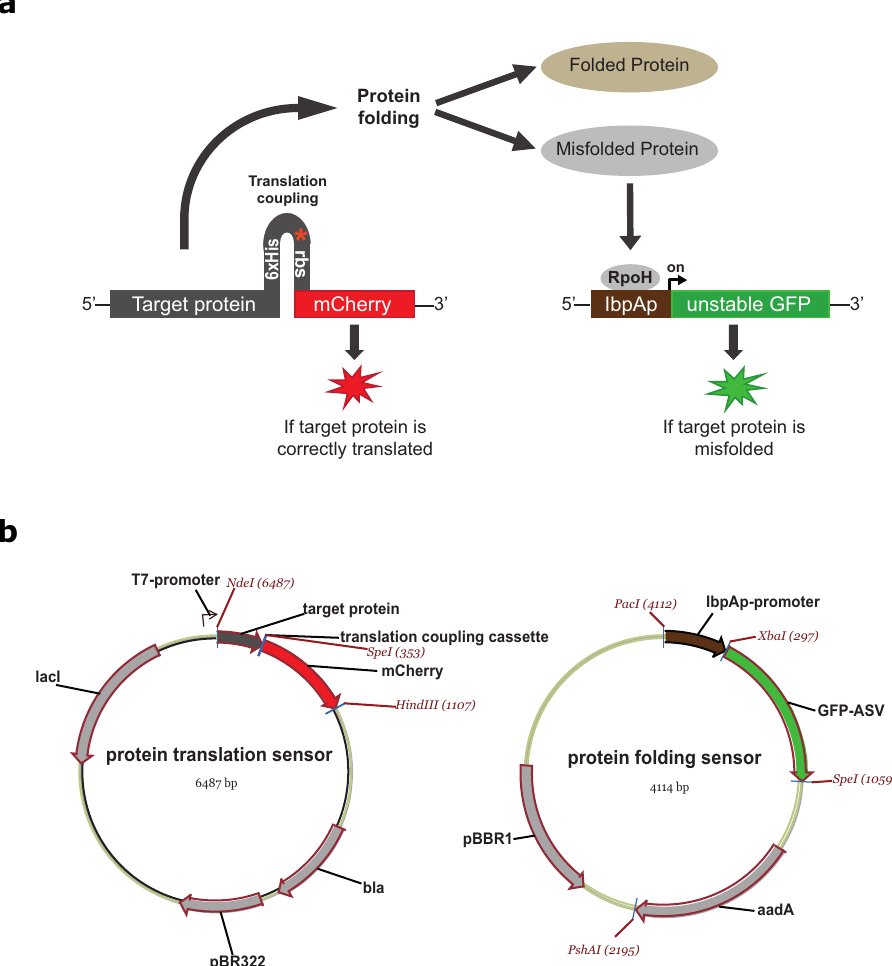
Fig. 1 Schematic overview of a dual-reporter system with simultaneous monitoring of protein translation and protein folding at the single cell level. a The translation sensor is comprised of the gene of interest translationally coupled to the reporter protein mCherry. When the target gene is correctly translated, the RNA polymerase unfolds the secondary structure and the mCherry gene is transcribed resulting in a red fl uorescent signal. The synthesized polypeptide chain then either folds into a soluble protein conformation or it fails to fold, thereby typically forming protein aggregates that accumulate as inclusion bodies. Formation of inclusion bodies increases the cellular level of free RpoH (heat shock sigma-factor σ 32 ). RpoH binds to the lbpA promoter in the protein folding sensor, initiating the expression of an unstable GFP variant, GFP-ASV, yielding a green fl uorescent signal. b Overview of the plasmids used for the protein translation and protein folding